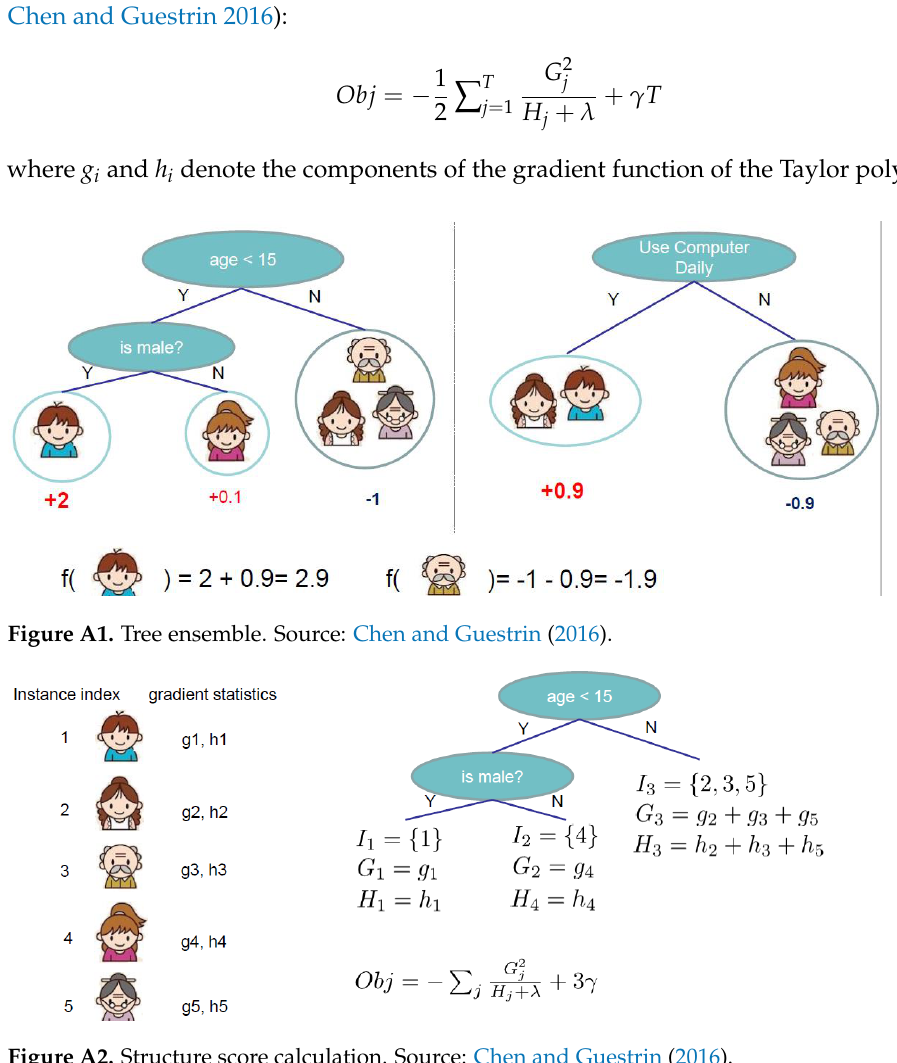
Figure A1. Tree ensemble. Source: Chen and Guestrin (2016).